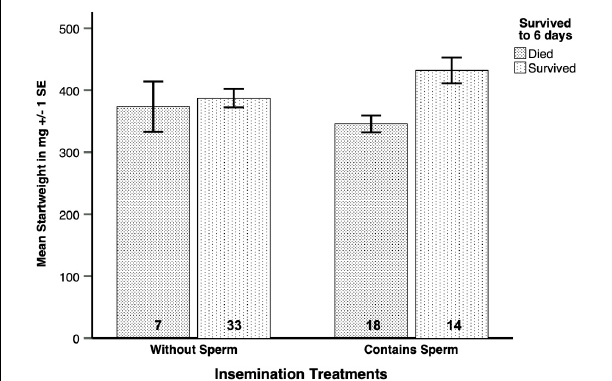
FIGURE 2 | After insemination with full ejaculates or sperm only, heavier queens of Atta colombica were more likely to survive until the end of the experiment than lighter ones. This interaction between body weight and survival was not significant for queens that had received a treatment not involving sperm ( Table 1 ).